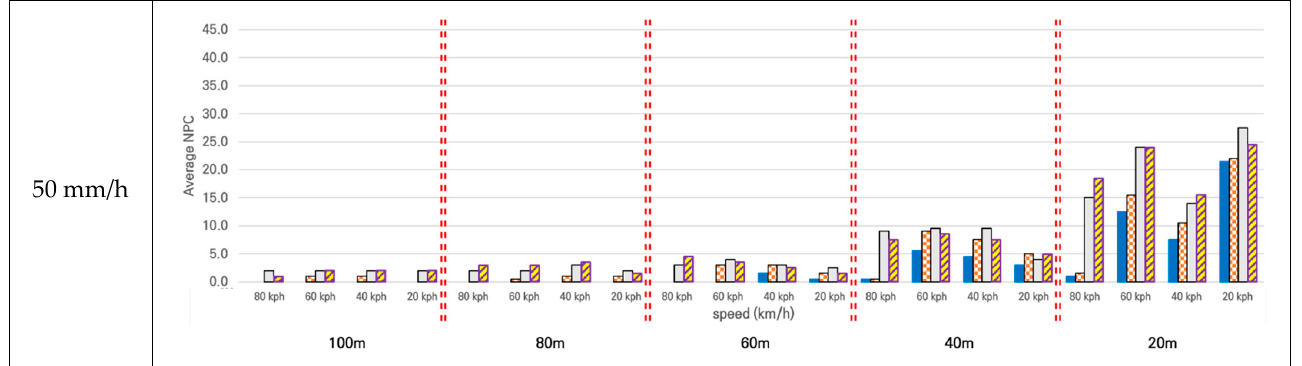
Figure 8. Average NPC at each distance for different amounts of rainfall.